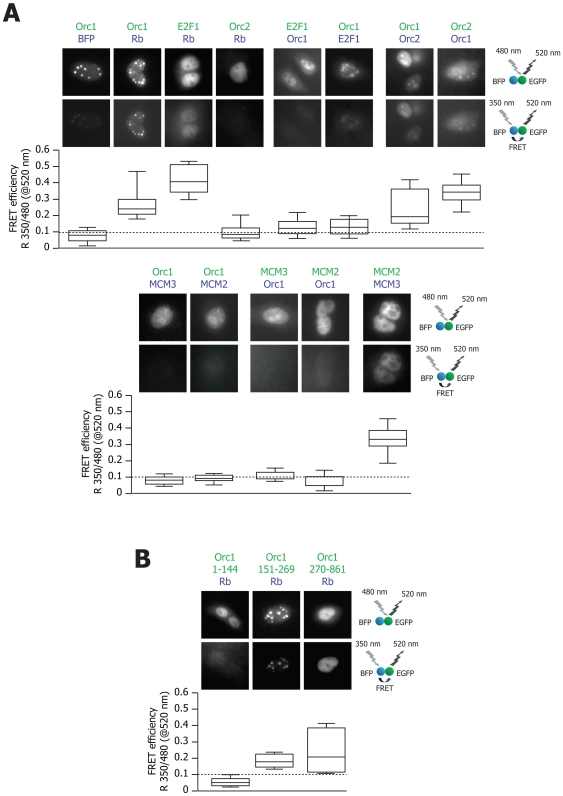
FRET analysis.(A) HeLa cells were transiently transfected with expression vectors coding for the proteins indicated on top of each panel fused to either EGFP (green color) or BFP (blue color). Individual transfected cells were visualized by excitation at 480 nm and collection at 520 nm, showing EGFP fluorescence after direct EGFP excitation (panels in the upper row), and by excitation at 350 nm and collection at 520 nm, showing EGFP fluorescence after BFP excitation, indicating FRET (panels in the lower row). The box plot below each image pair shows the quantification of FRET. Fluorescent emission at 520 nm from individual cells was recorded after excitation at 350 or 480 nm, and integrated intensities over the whole cell were evaluated. The percentile box-plot distribution of the ratio between these two measurements is shown by considering at least 10 consecutively analyzed cells for each protein pair. Horizontal lines of the percentile box plot distribution, from top to bottom, mark the 10th, 25th, 50th, 75th, and 90th percentile respectively. (B) FRET between Rb, tagged with BFP, and the same set of Orc1 truncation mutants considered for the GST pulldown experiments, tagged with EGFP.